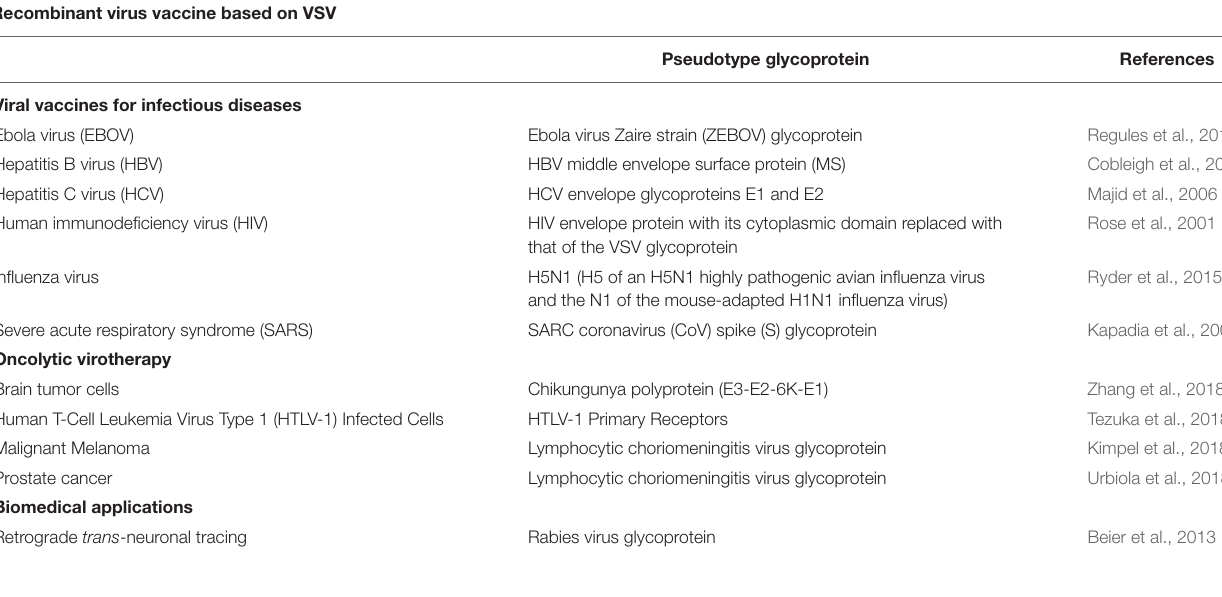
TABLE 5 | List of some of the animal rhabdoviruses that have been reverse engineered for various medical applications. Recombinant virus vaccine based on VSV